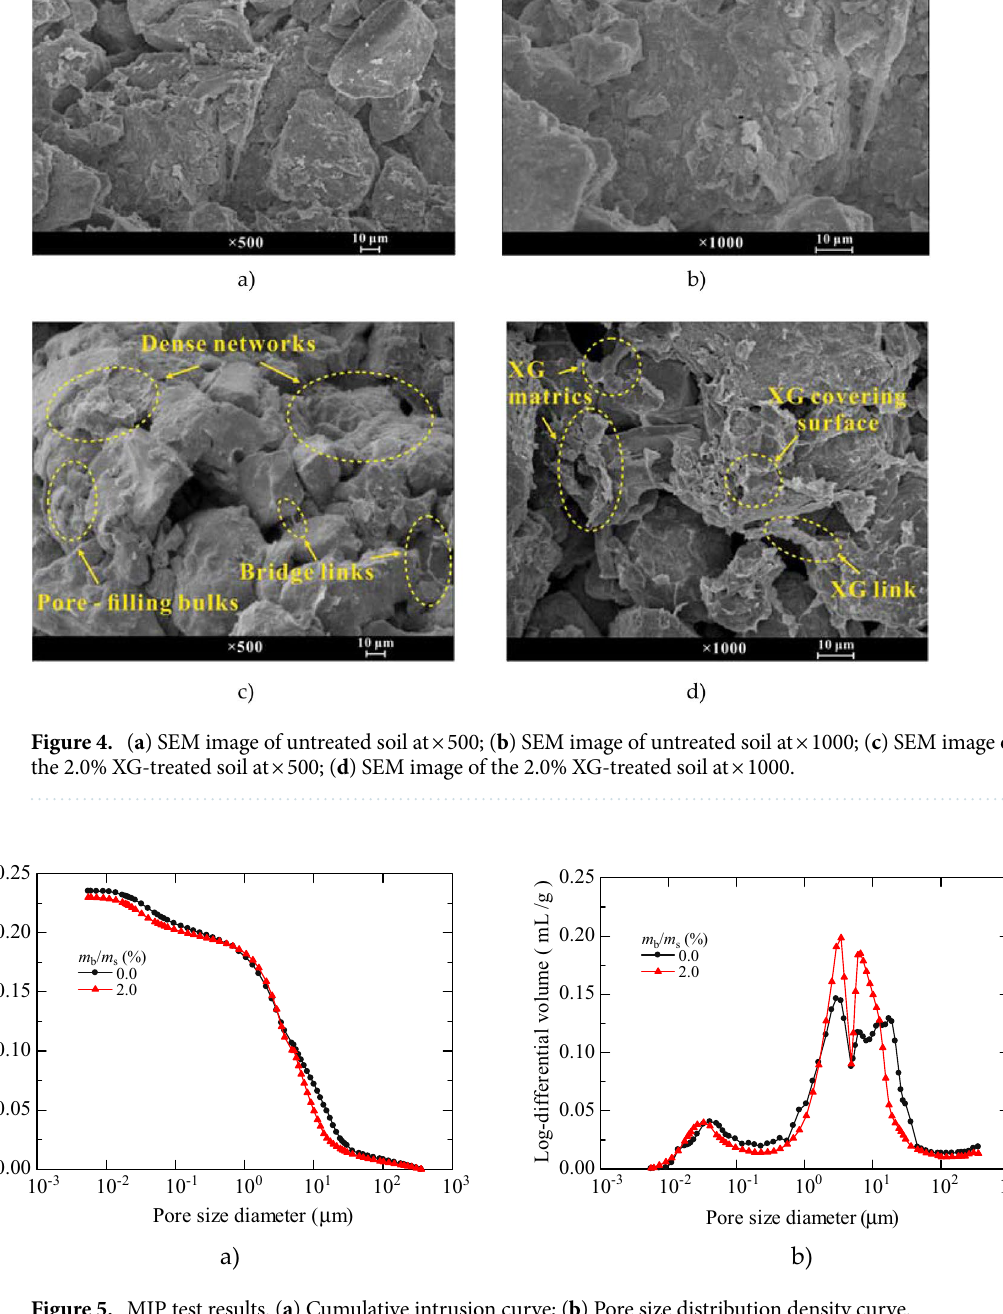
Figure 5. MIP test results. ( a ) Cumulative intrusion curve; ( b ) Pore size distribution density